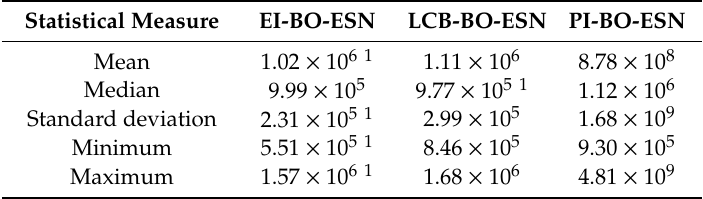
Table 4. Statistical measures of best fit MSE values found over the 50 runs on the Brazilian